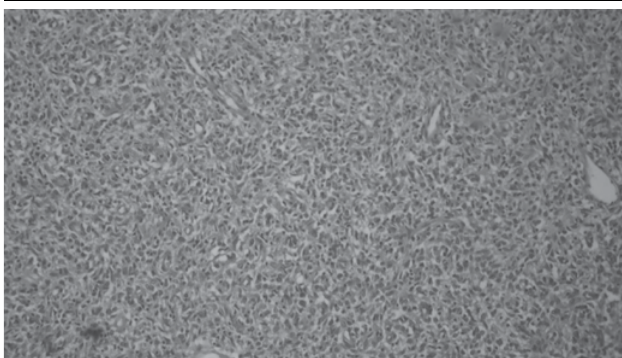
figurE 2 – Histological sections studied in routine staining (H&E) showed a spindle cells proliferation surrounded by a fibrous and collagen stroma in between pattern. Hemangiopericytoma-like vascular arrangements are observed H&E: hematoxylin and eosin.